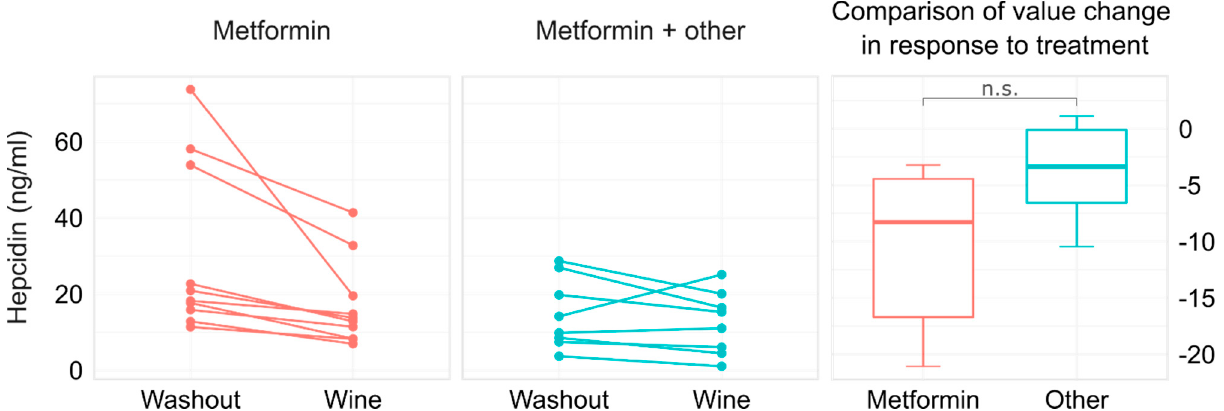
Figure 3. Value changes in hepcidin after 3-week moderate intake of red wine in the patients with type 2 diabetes taking only metformin ( n = 10) and those taking metformin with other oral antidiabetic agents ( n = 8). The abbreviation n.s. indicates p > 0.05.